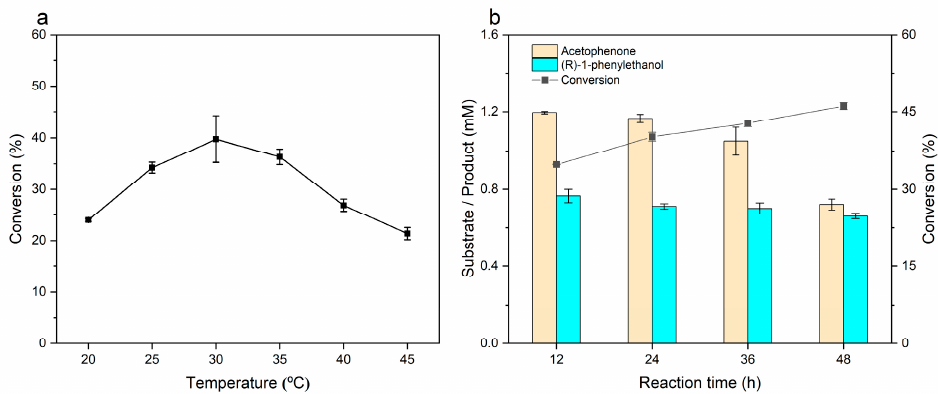
Figure 4. Effect of temperature ( a ) and reaction time ( b ) on the B. cereus TQ-2-catalyzed bioreduction of acetophenone. The general reaction conditions used otherwise stated: 2 mM of substrate, 0.1 g/mL of microbial cells, 5 mL of phosphate buffer (100 mM, pH 7.4), and 600 rpm; ( a ) increased reaction temperature from 20 °C to 45 °C; ( b ) prolonged reaction time from 12 h to 48 h.